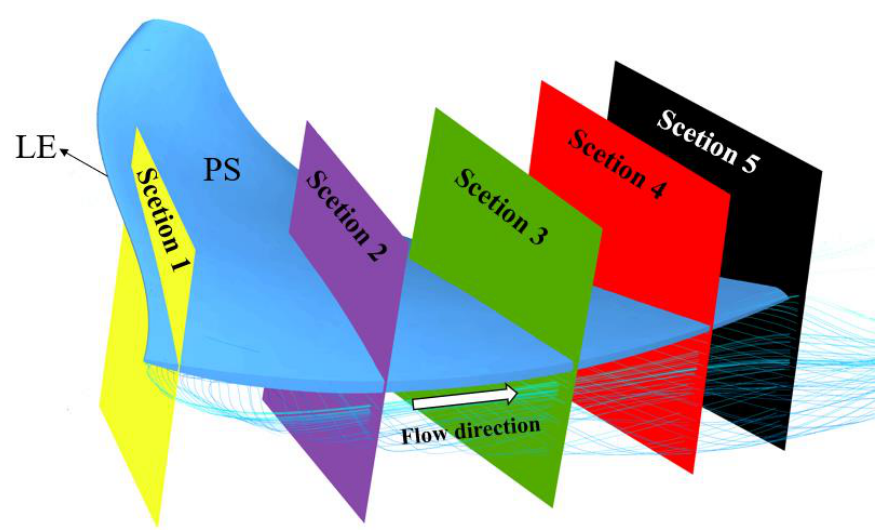
Figure 13. Schematic cross-sectional view along the flow direction.